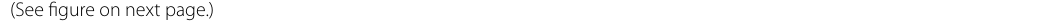
(See figure on next Fig. 2 Microbial Characterization of piglet fecal microbiota utilizing metagenomics. Differences in microbial communities in MSP and control group at 6 weeks (n 9 per group). Violin plots reflect differences in bacterial diversity in fecal microbiota according to the Shannon index and Chao = richness. A Shannon diversity representing alpha diversity and B Chao diversity. C , D Nonmetric multidimensional scaling analysis of weighted and unweighted UniFrac distance. Relative abundance of 10 dominant OTUs in MSP group piglet fecal microbiota at family level E and genus level F . Relative abundance of 10 dominant OTUs in control group piglet fecal microbiota at family level G and genus level H